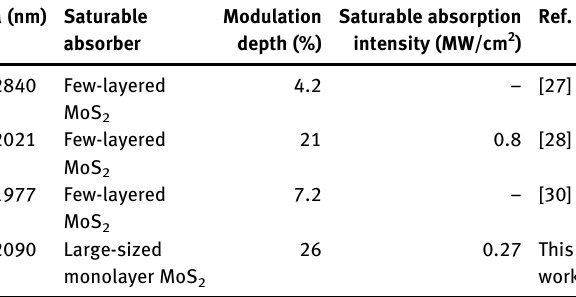
Table  : Comparisons of saturable absorption properties of mo- lybdenum disul fi de (MoS  ) saturable absorber in the mid-infrared (MIR) band.